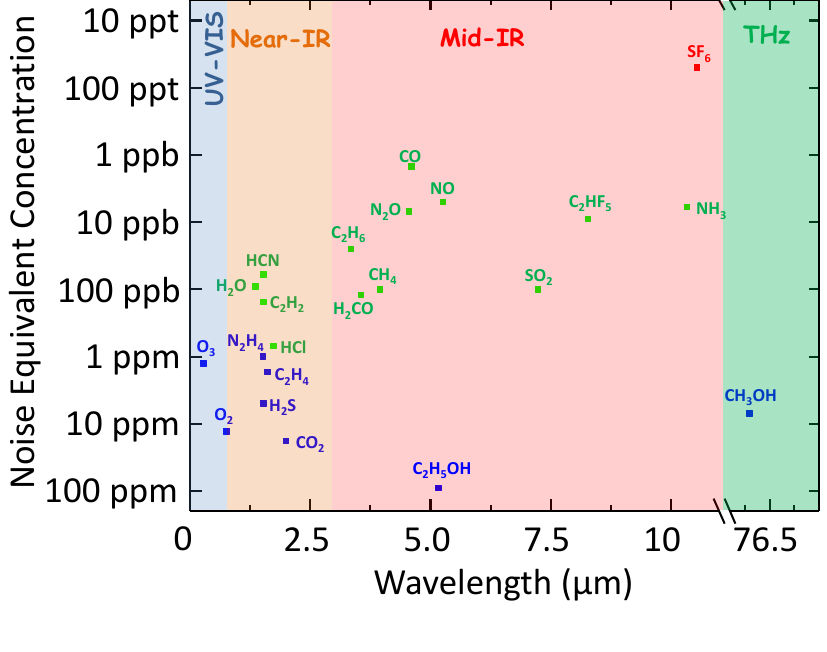
Figure 18. Best NEC results for the gases listed in Table 2 versus employed laser wavelength, in the UV-Vis, near-IR, mid-IR and THz spectral ranges. The blue, the green and the red symbols indicate NEC values in the ppm, ppb and ppt concentration ranges,